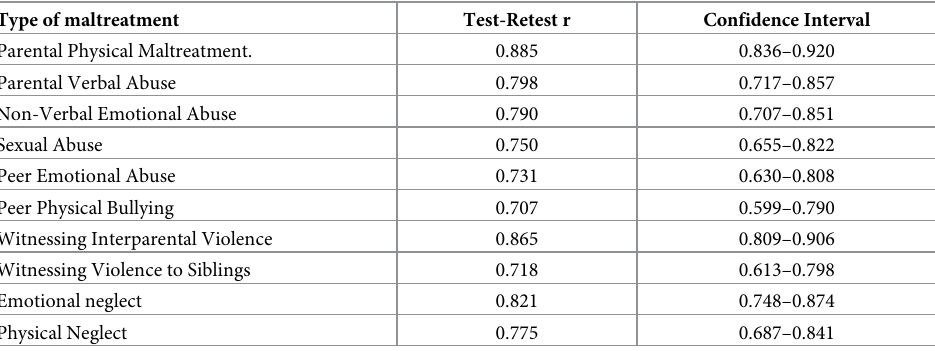
Table 11. Test–retest reliability by